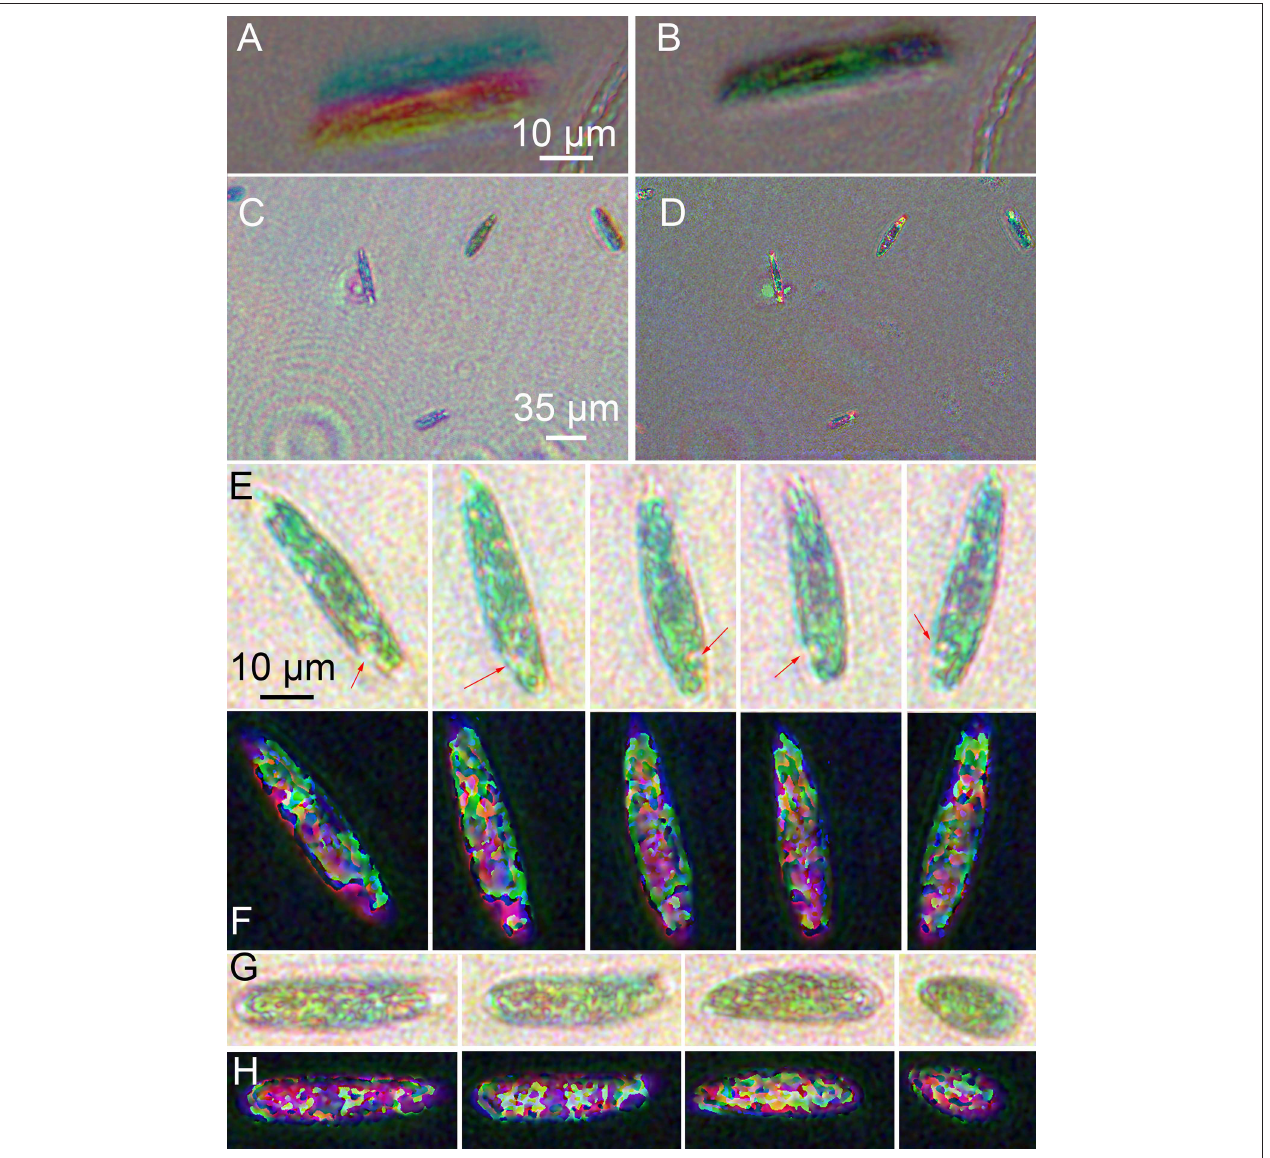
FIGURE 7 | Images of wild-type Euglena reconstructed at a single focal plane. (A) Amplitude image of a single cell before registration. (B) Image after multi-point registration. All following images have been registered. (C) Amplitude, wide field of view. (D) Phase, wide field of view. (E) Amplitude reconstruction of a single cell rotating as it swam in x and y with minimal change in z. Scale bar applies to all panels (E–H) . The arrows indicate the eyespot. (F) Phase reconstruction of rotating cell. (G) Amplitude reconstruction of a cell contracting. (H) Phase reconstruction of contracting cell.